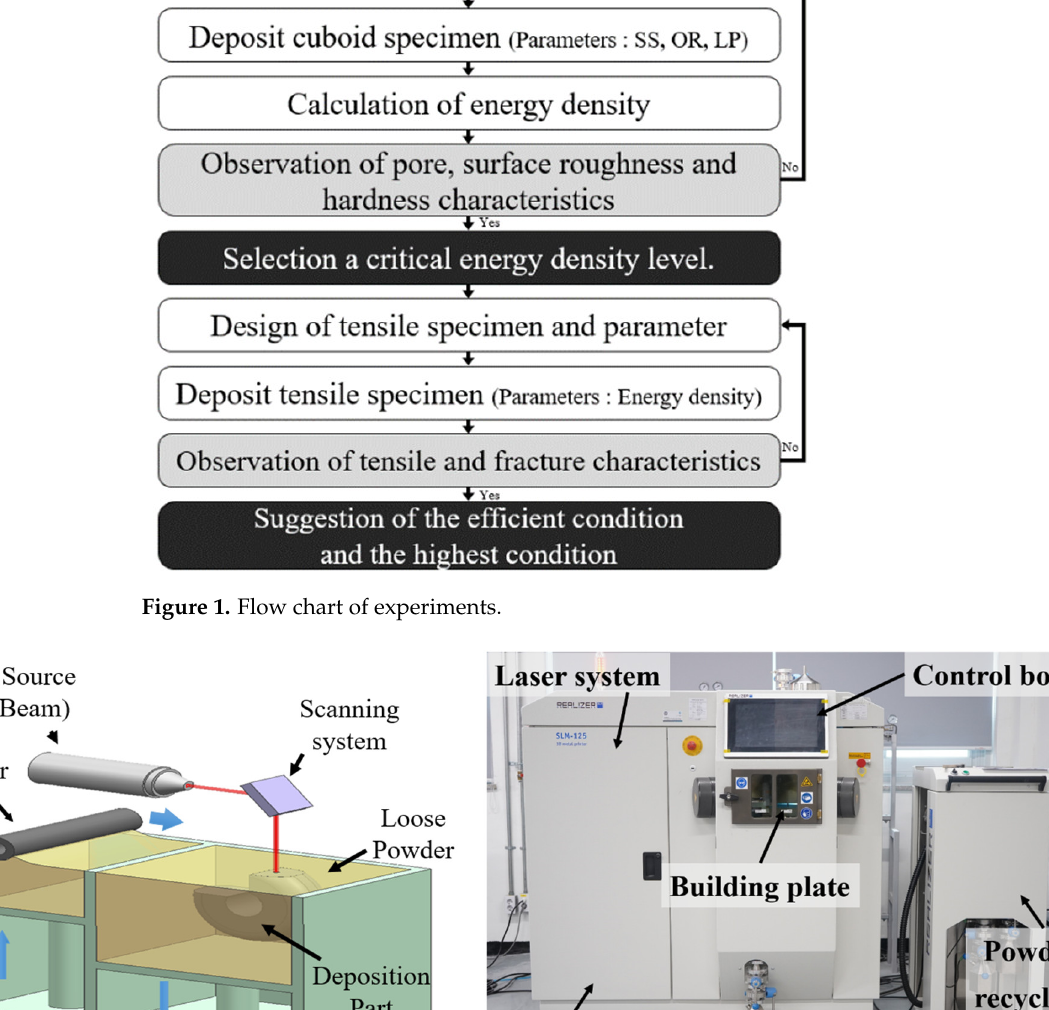
Figure 2. Conceptual diagram and experimental set-up of PBF process: ( a ) conceptual diagram of PBF process and ( b ) experimental set-up of PBF process.